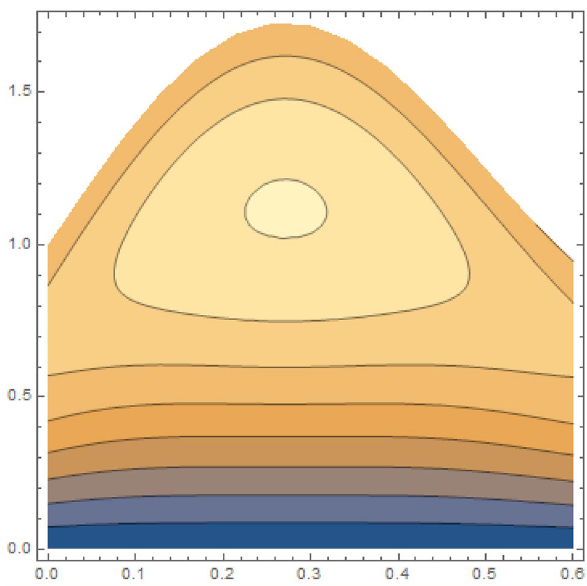
Figure 24. Streamlines of M = 2.0.